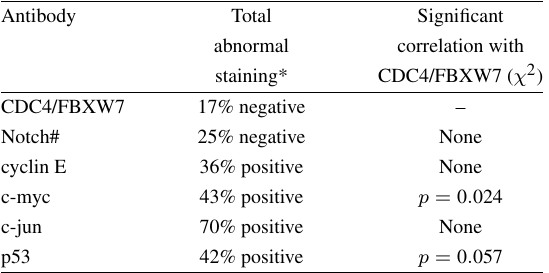
TMA immunohistochemistry together with statistical correlation with